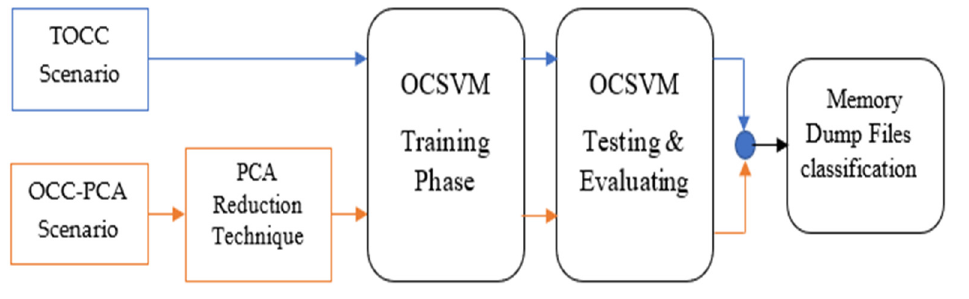
Figure 2. The Proposed Scenarios for OCC ‐ PCA and TOCC